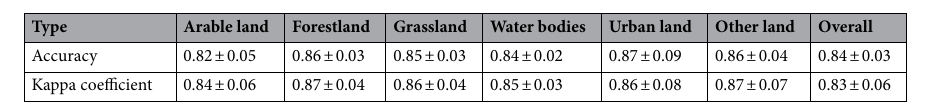
Table 2. The accuracy assessment of land use interpretation from 1990 to 2016.